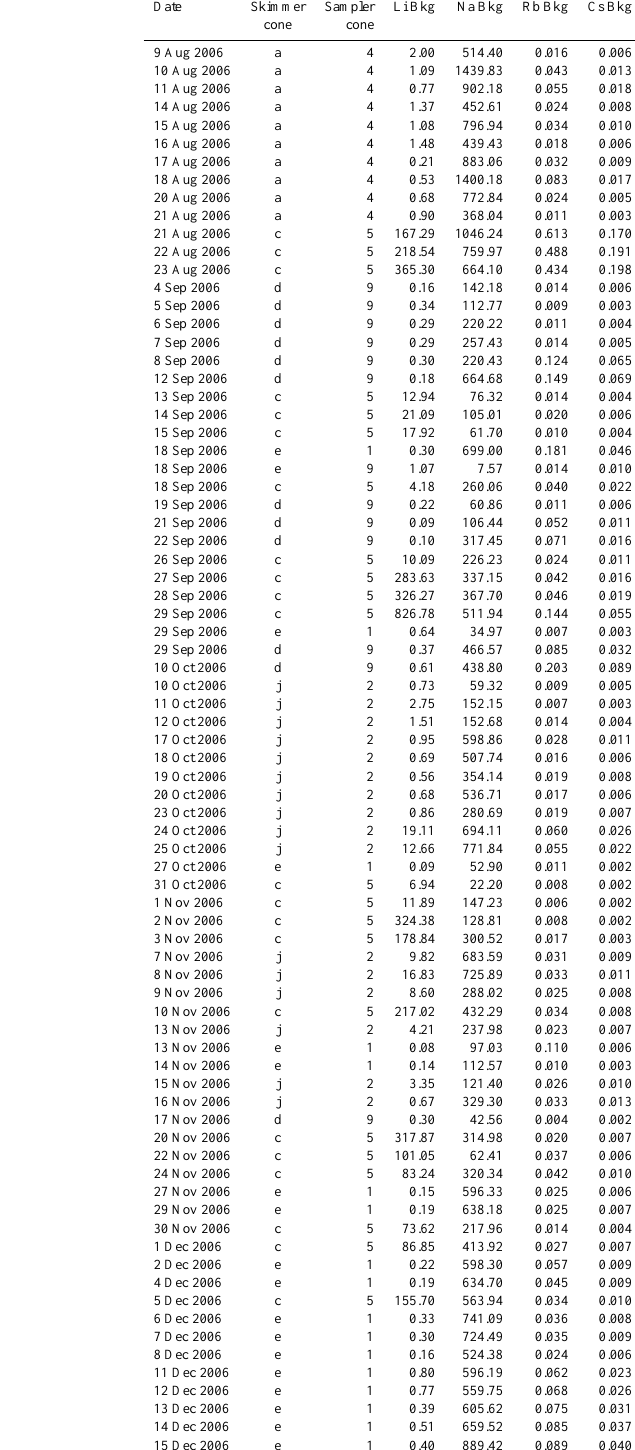
Table 4a. Mean daily backgrounds in µgg − 1 equivalent from tun- ing using the NIST 612 glass.